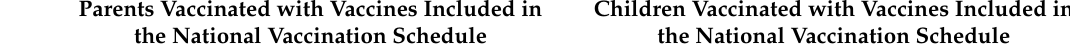
Table 4. Vaccination of adults and children with the mandatory vaccines included in the national scheme.